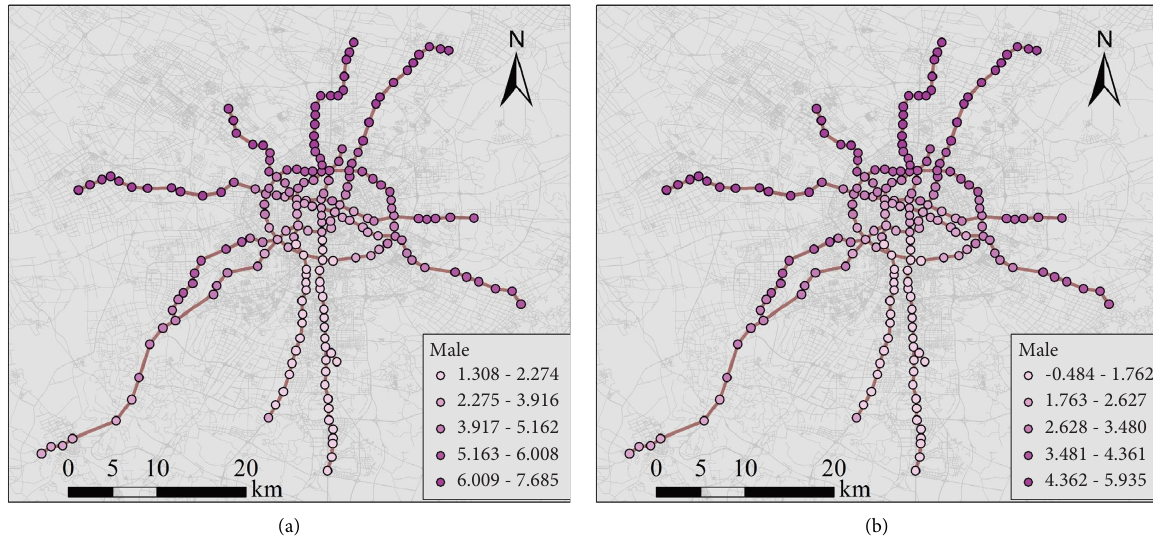
Figure 9: Spatially varying efects of male on the access/egress distance. (a) Efects of male on the access distance and (b) efects of male on the egress